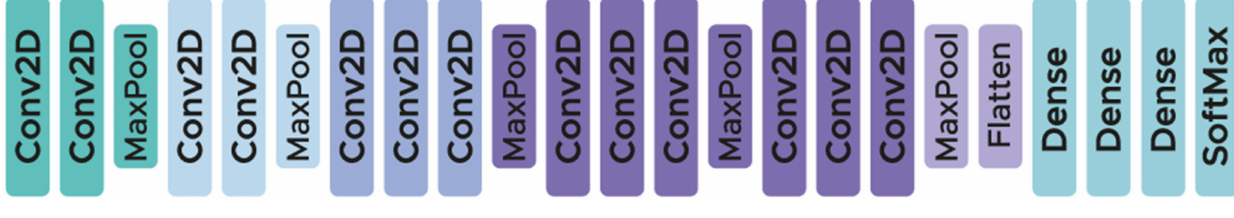
Figure 7. The structure of VGG16.